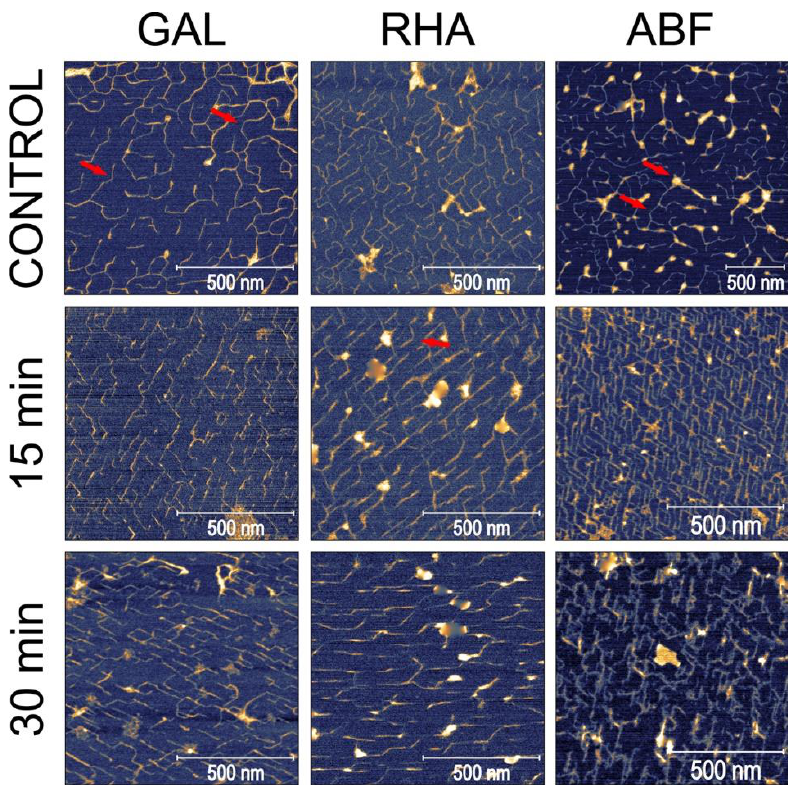
Figure 1. Sample images of DASP treated with GAL, RHA and ABF with respect to the duration of enzyme treatment (arrows indicate local bend points and aggregates).